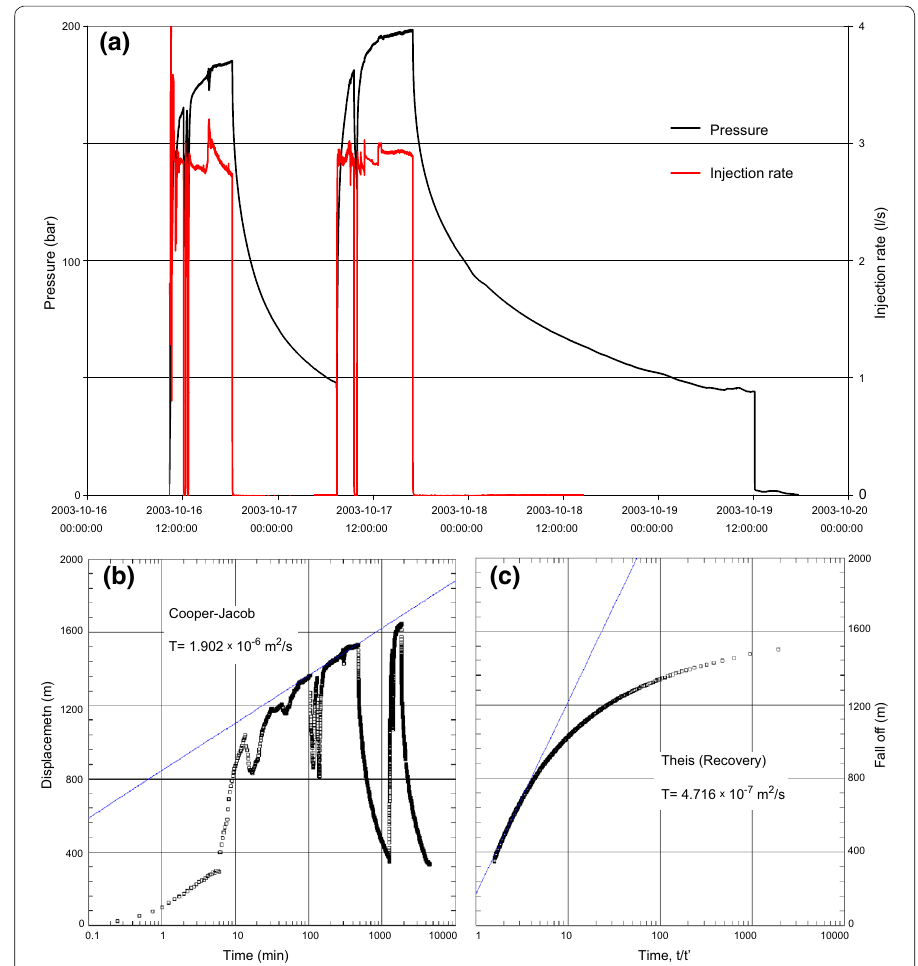
Fig. 10 a Recorded data from injection and fall‑off tests conducted in the open‑hole section between 3198 and 3701.8 m. b Semi‑logarithmic plot of the acquired pressure data, converted from bar to meters of water column. A straight line is fitted to the data for the first injection test and the Cooper–Jacob method is applied for estimating the transmissivity. c Transmissivity estimated from the first fall‑off using Theis recovery method (Modified from Rosberg